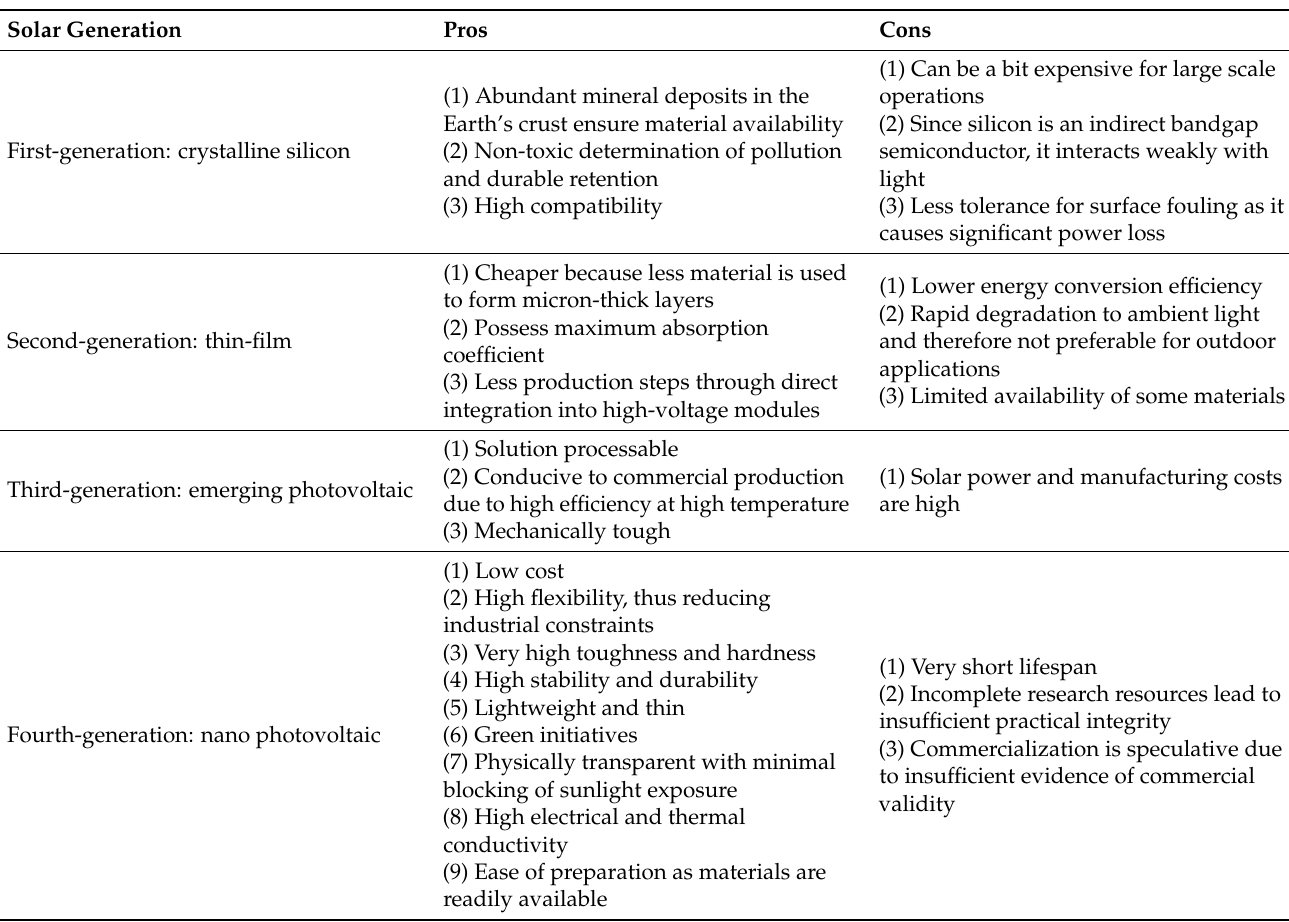
Table 5. Pros and cons [52–54] of solar cells explained under the generation